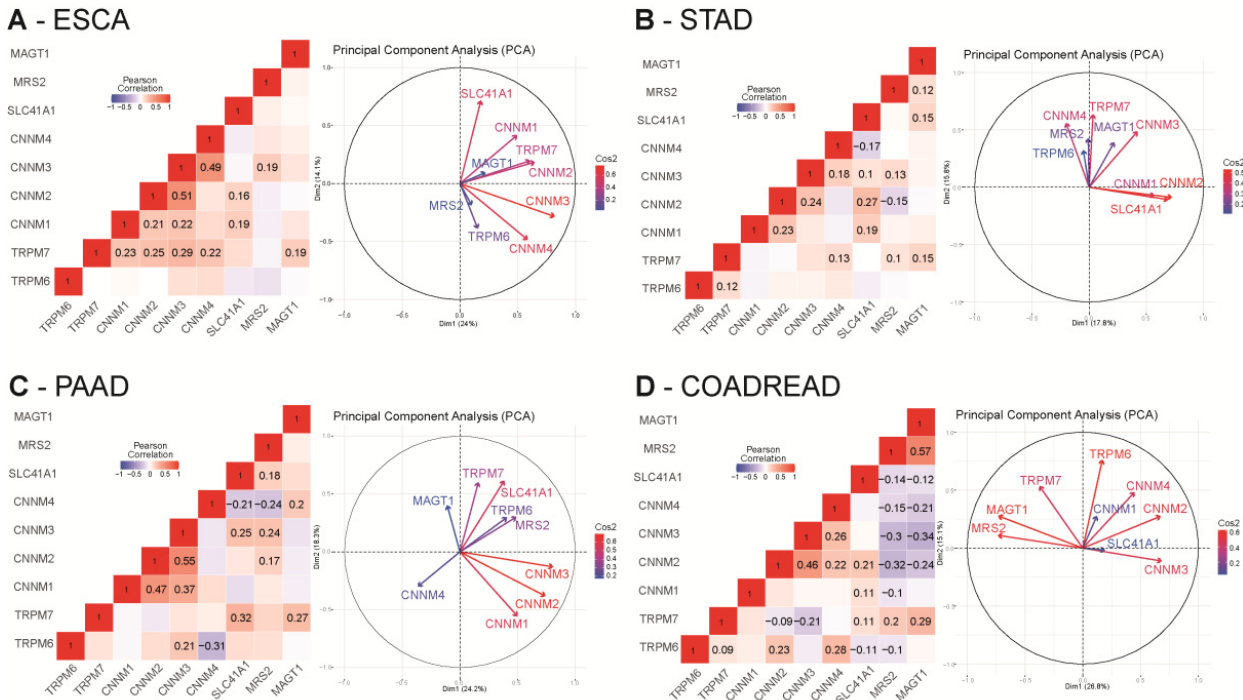
Figure 5. Correlation analysis of relative magnesium transporters mRNA levels in digestive cancers TCGA cohorts. Pearson cor-relation R values were calculated for each magnesium transporter mRNA using RStudio. All queries for TRPM6, TRPM7, MAGT1, SLC41A1, MRS2, CNNM1, CNNM2, CNNM3 and CNNM4 genes were realized in ESCA ( A ), STAD ( B ), PAAD ( C ) and COAD-READ ( D ) datasets from TCGA using the cBioPortal website. mRNA expression values were retrieved as RNA-Seq by Expectation Maximization RSEM (Batch normalized from Illumina HiSeq_RNASeqV2). Only significative correlations values ( p < 0.05) are presented. Principal component analysis (PCA) of Mg2+ transporters mRNA relative expression in TCGA datasets are also represented. Grouped variables are positively correlated whereas opposed variables are negatively correlated. Independency of the variables is formed by a 90° angle formed by two arrows. The quality of the variables on the Principal Component Analysis (PCA) are designated by Cos2 (square cosine, squared coordinates) values.